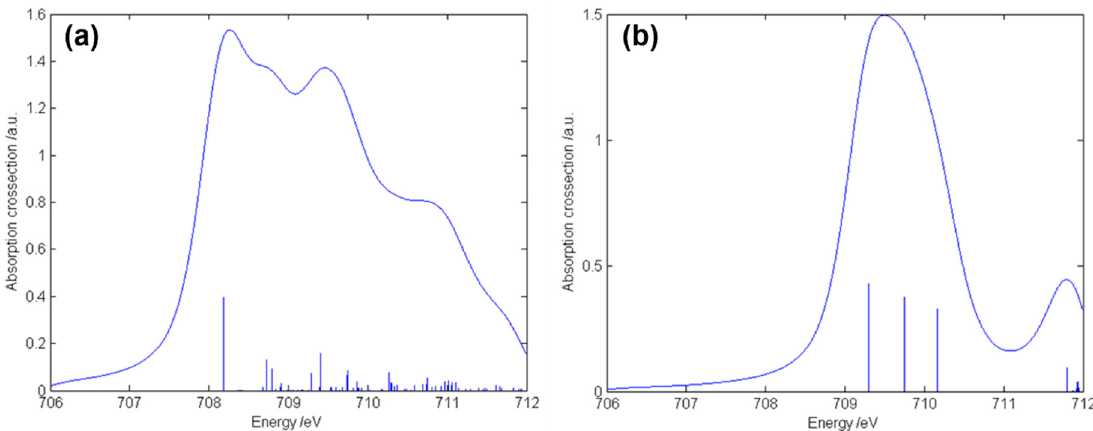
Figure 3. The Fe 2p high-energy resolution spectra of ( a ) Fe 2+ and ( b ) Fe 3+ by charge transfer multiples for the X-ray absorption spectroscopy (CTM4XAS) program that was developed by E. Stavitski and F.M.F.de Groot [17,18].